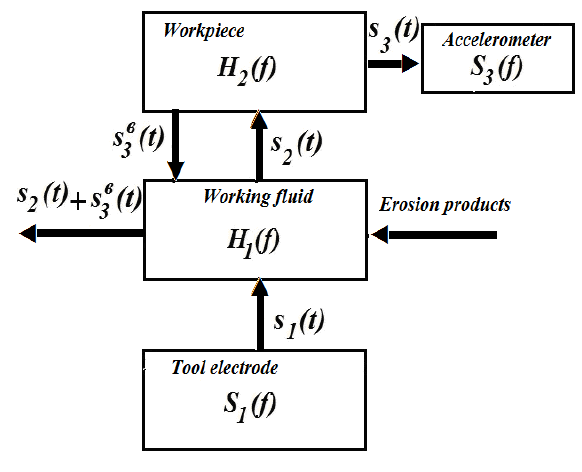
Fig. 4. Diagram of the dynamic system exposed to EDM The pulses passed through working fluid and modified within it, (process s2(t)), have a dynamic influence on the elastic system from element having dynamic value with a module of transfer function